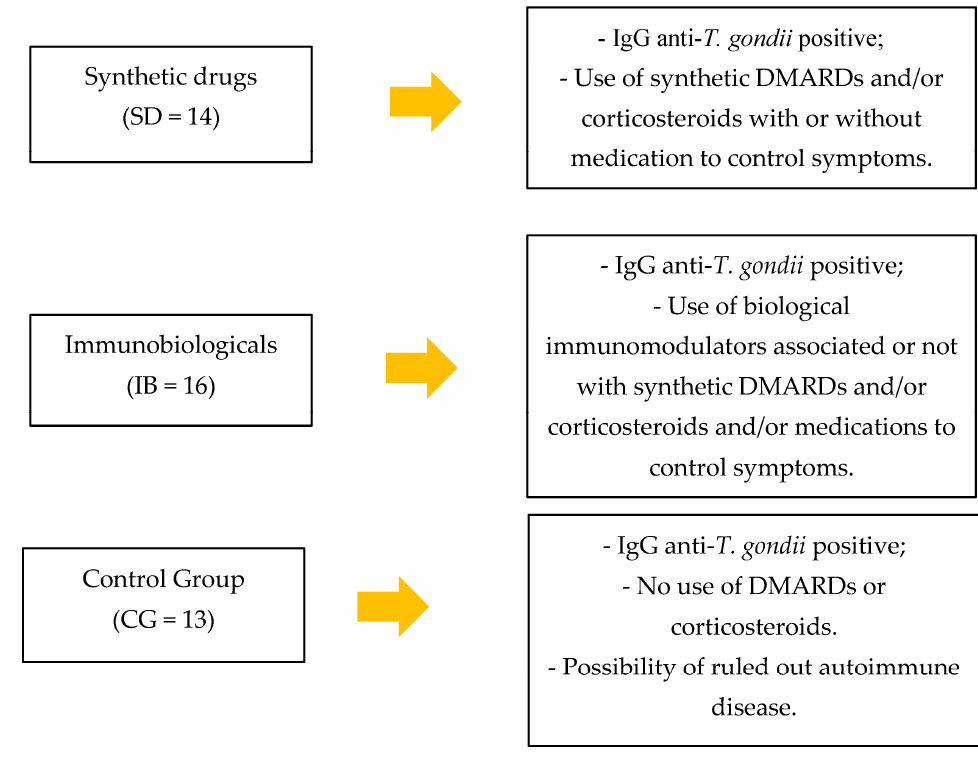
Figure 1. Scheme of division of groups.